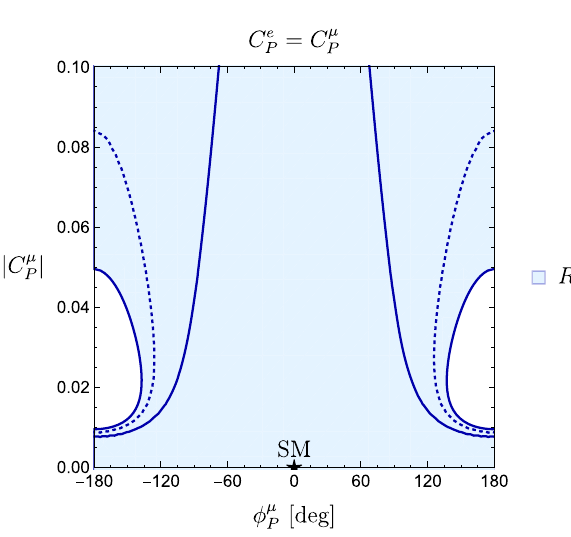
Fig. 3 New physics regions in the φ universality for the pseudoscalar Wilson coefficients of μ and τ